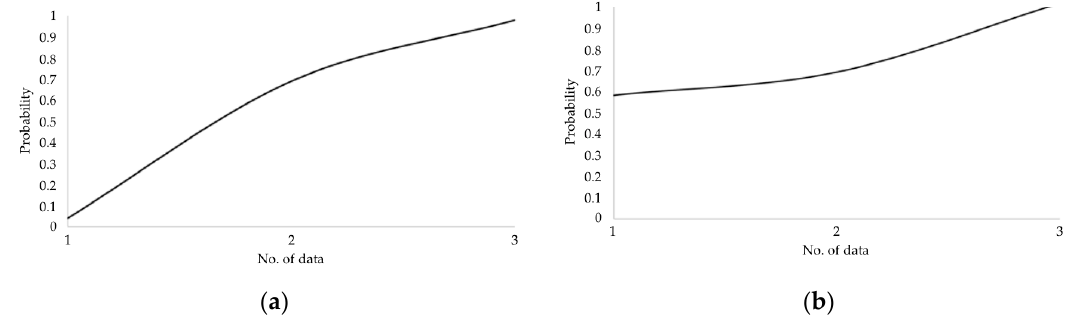
Figure 7. Distribution of probability model (Equation (2)) when applied to data in Table 6. The model realistically approximates the probability distribution ( a ) and the carrying capacity ( b ) when the model runs with the whole dataset.